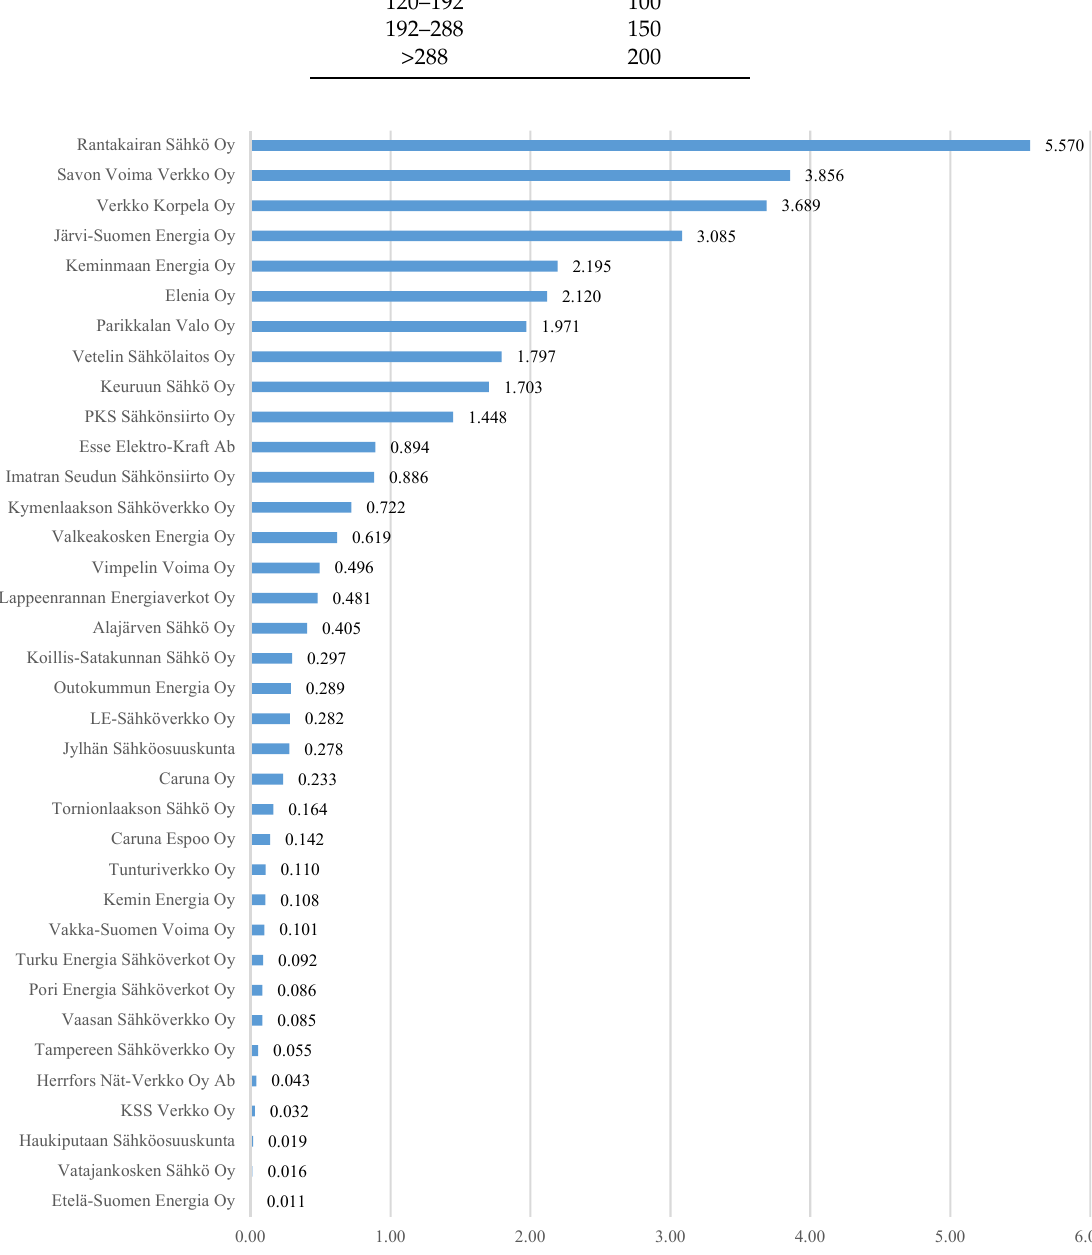
Figure 2. Compensation price of one minute of interruption during 2015 (€ cents).